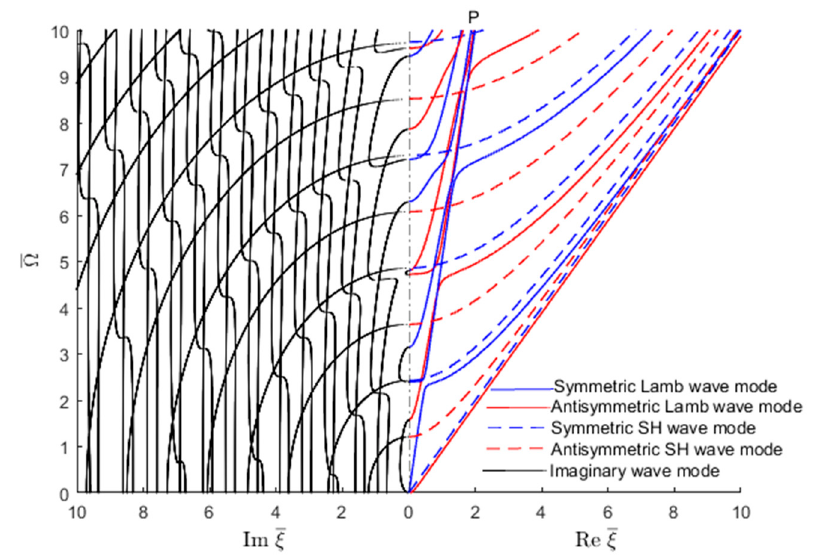
Figure 14. Real and imaginary wavenumber solution of GWs for CFRP composites.